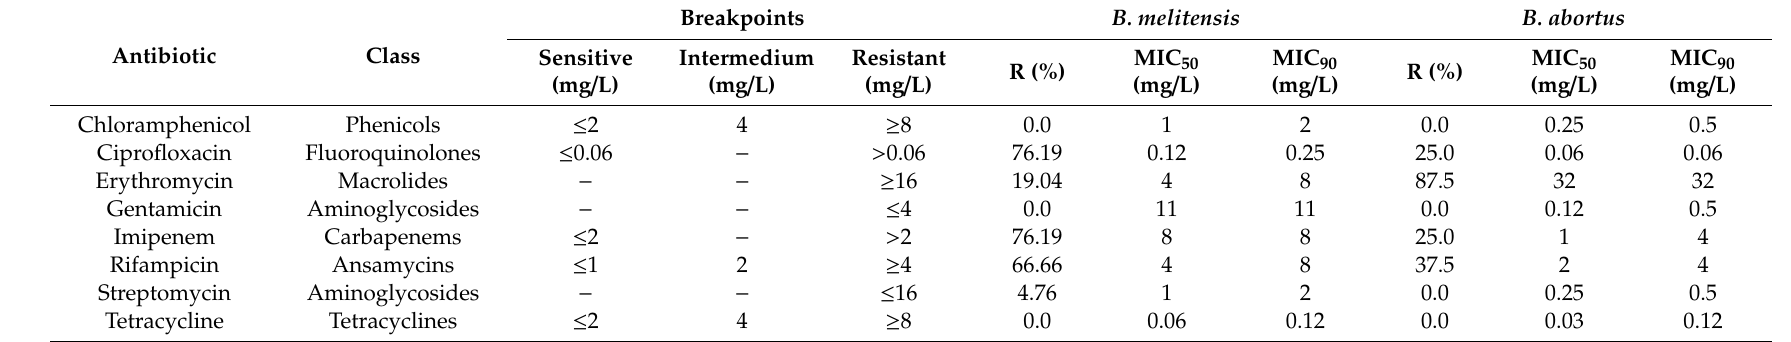
Table 2. Antimicrobial resistance profiles of 21 B. melitensis and 8 B. abortus isolated from livestock species in Egypt against 8 clinically used antibiotics using E -test. Breakpoint and Minimal Inhibitory Concentration (MIC 50 , MIC 90 ) for B. melitensis and B. abortus used in this study according to CLSI and EUCAST recorded for H. influenzae [57,58] were